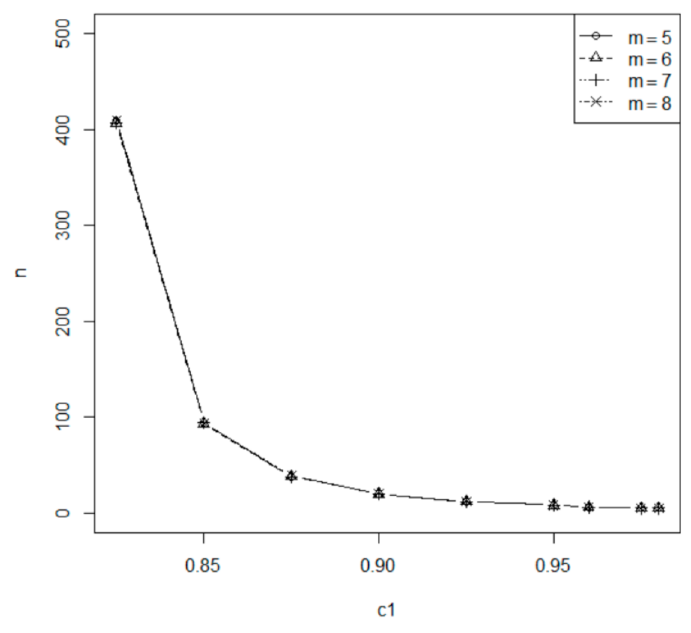
Figure 2. Minimum sample size for the test at α = 0.05, β = 0.2, and p = 0.05.